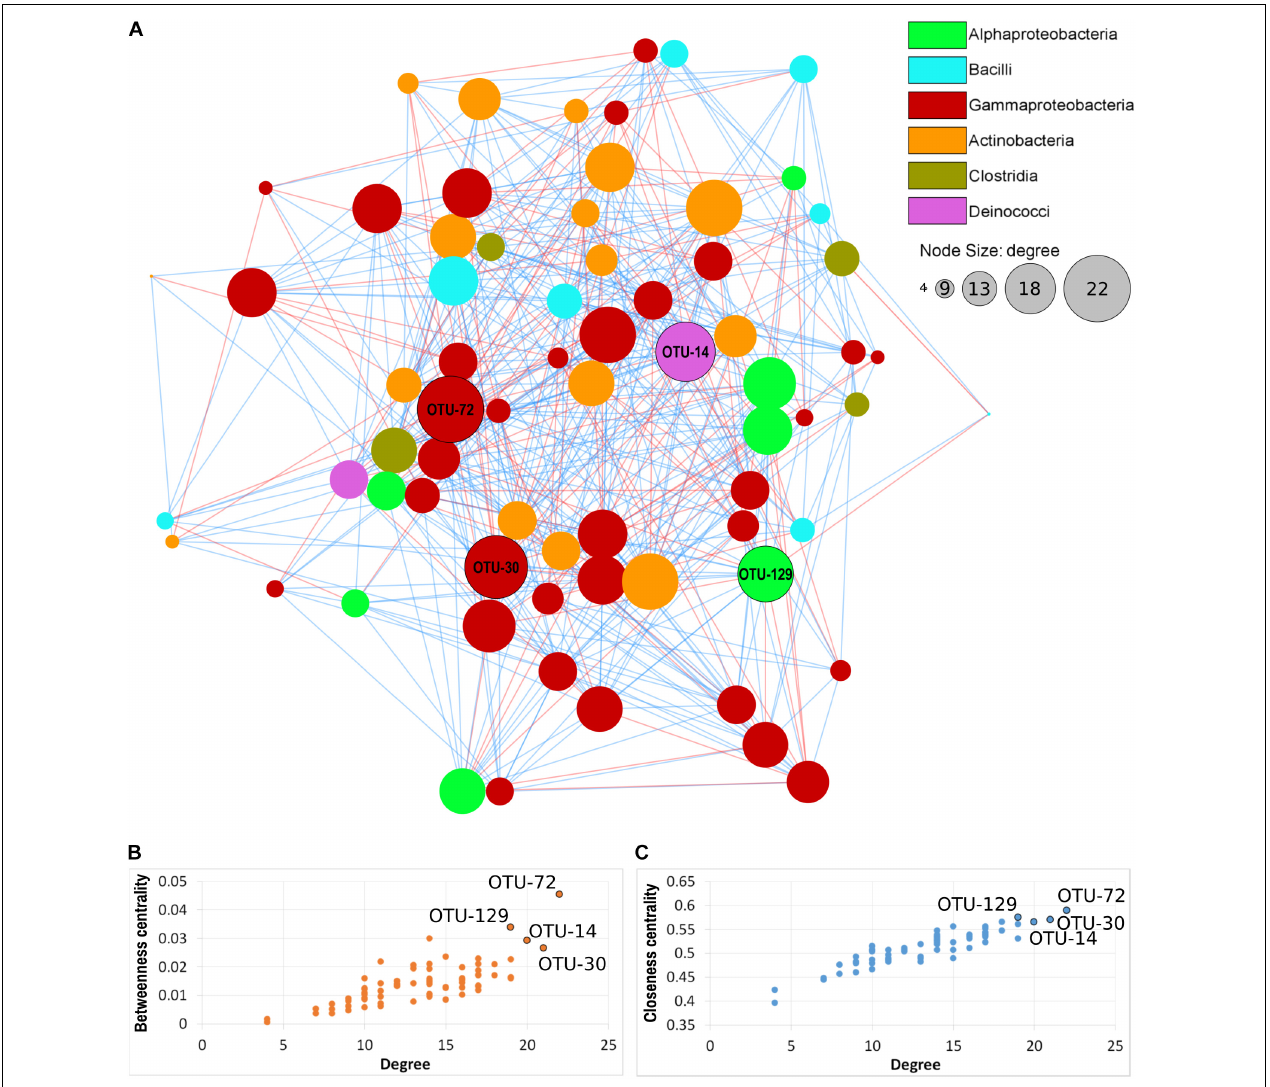
FIGURE 7 | Microbial co-occurrence network of the orchid microbiota. (A) Nodes represent OTUs, edges represent positive (blue lines) or negative (red lines) correlations. Node size indicates the degree (number of connections) and node color indicate the taxonomical class, according to the legend. Labeled nodes represent the hub OTUs. (B,C) Connectivity scores of the nodes, based on degree, betweenness centrality and closeness centrality, used to identify the hub OTUs (labeled